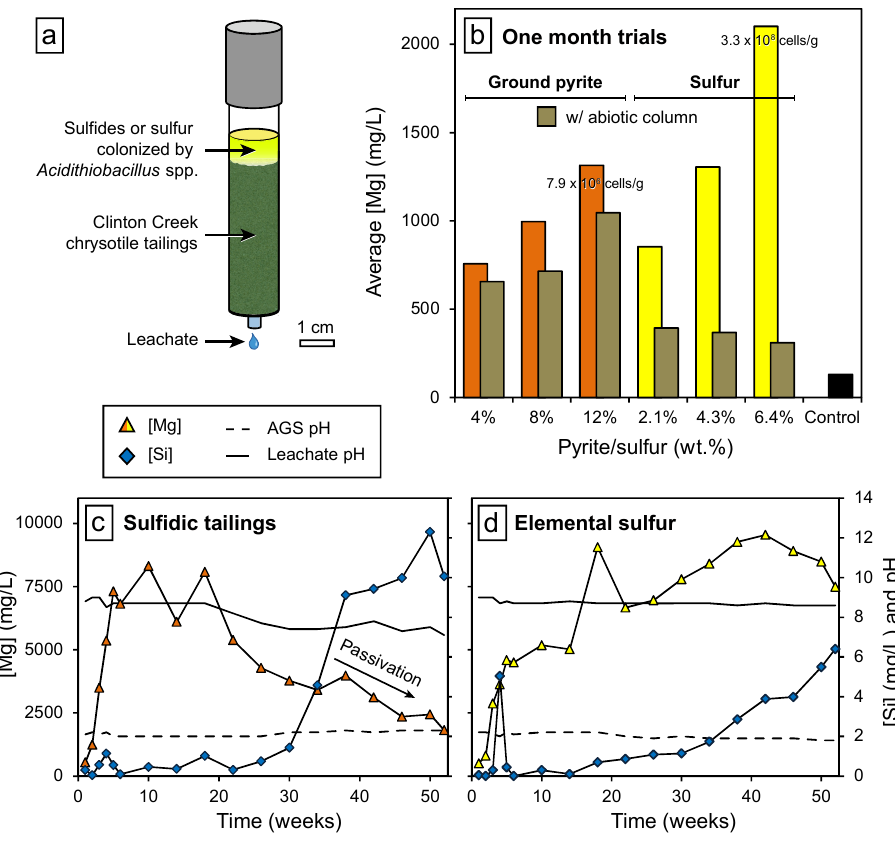
Figure 4. Bioleaching of ultramafic mine tailings (after Power et al . [13]). ( a ) Schematic of a bioleaching column using an acid-generating substance colonized by Acidithiobacillus spp. for accelerating dissolution of Clinton Creek chrysotile tailings. ( b ) Average Mg concentration of leachate from one-month column experiments with comparison to abiotic controls and a control lacking pyrite and sulfur. ( c , d ) Plots of Mg (triangles) and Si (diamonds) concentrations versus time from year-long trials. pH of the sulfidic tailings and elemental sulfur (dashed lines) and the leachate solutions (solid lines) are also